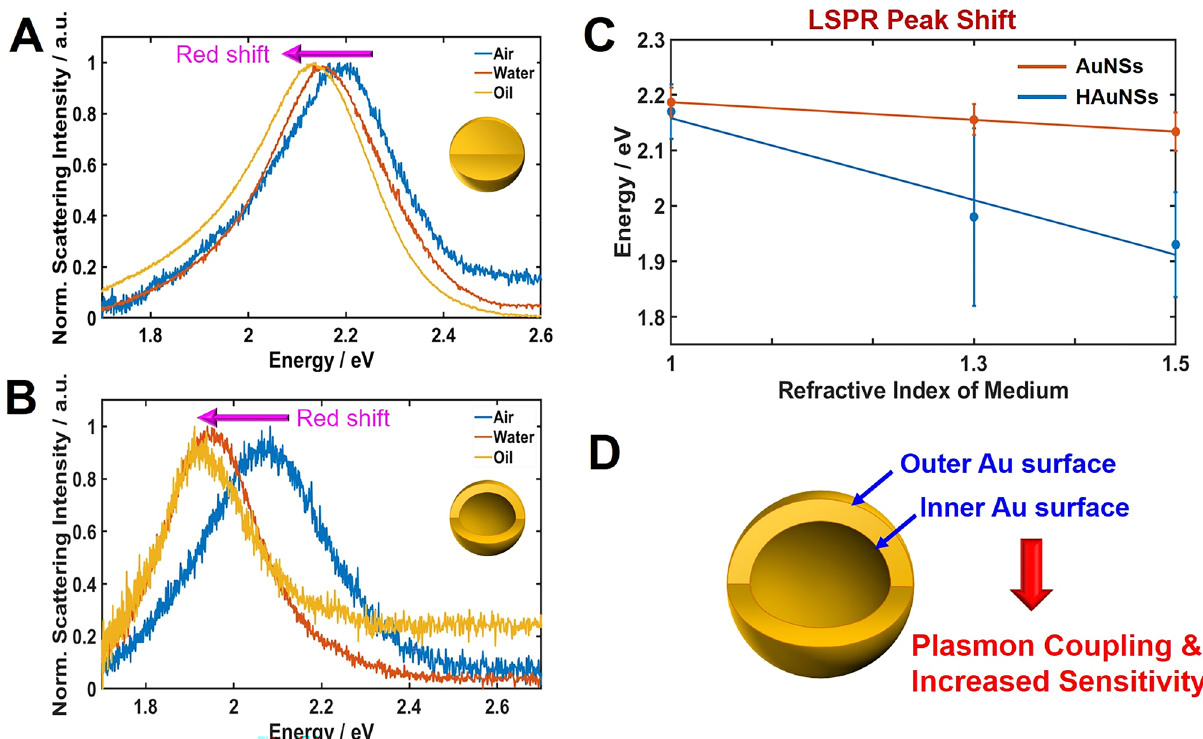
Figure 3. Change in the LSPR scattering spectra of single AuNS ( A ) and HAuNS ( B ) in the different local RI media: air, water, oil. ( C ) LSPR wavelength shifts for AuNS (red) and HAuNS (blue) as a function of the local RI of medium. ( D ) Schematic to show plasmonic coupling between the inner and outer surface of the Au RI media used. The energy peaks for A, B, and C were plotted against the three different RI media (air, water, and oil) with corresponding values equal to 1.00, 1.33, and 1.52, respectively (Fig. 4D). A linear relationship was observed between the peak energies for A, B, and C and the local RI media. The slopes that were determined from a fitting function were 0.153 (R 2 = 0.9398), 0.105 (R 2 = 0.9983), and 0.048 eV·RIU −1 (R 2 = 0.9895) for A, B, and C, respectively. It should be noted that the IF in A at longer wavelength sides exhibited a better sensitivity with regard to the IF in C at the shorter wavelengths side. The LSPR peak maxima (B) is shown in Fig. 4E. It should be noted that LSPR IF A at the longer wavelength side showed the highest sensitivity in regard to LSPR IF C (shorter wavelength side) and the LSPR maxima peak (B) as presented in Fig. 4E. To deepen our understanding on the effect of inner cavity of HAuNSs on the RI sensitivity of the LSPR IFs, scattering experiments using DF microscopy and spectroscopy were carried out for HAuNSs. The RI sensitivity of HAuNSs at the LSPR IFs was compared with solid AuNSs with similar size as shown in Fig. 4. Similar to AuNSs in Fig. 4, the first- and second-derivatives of the LSPR scattering spectra of HAuNSs were also obtained. The experimental LSPR scattering spectra of a single HAuNS and its corresponding first- and second-order deriva- tives are shown in the first, second and third rows of Fig. 5A–C, respectively. The LSPR scattering peak maxima (B) were located at 2.09, 1.95 and 1.91 eV for air, water and oil, respectively. The local maxima and minima of the first-order derivatives (two LSPR IFs shown by markers in A and C, respectively) occurred at 1.99/2.19, 1.85/2.03 and 1.82/2.01 (eV/eV) for the three different RI media (air, water, and oil), respectively. To check the compatibility of the experimental results shown in Fig. 5, we measured the LSPR scattering spectra of more than 20 HAuNSs in each local RI environment. The experimental data showed good agreement for all the HAuNSs analyzed. The LSPR peak maxima (B) were 2.08 (± 0.026), 1.98 (± 0.028), and 1.92 (± 0.037) eV for air, water and oil, respectively. Similarly, the LSPR IFs, A and C, were 1.98 (± 0.049) and 2.22 (± 0.049), 1.84 (± 0.160) and 2.05 (± 0.160), and 1.82 (± 0.094) and 2.02 (± 0.094) eV, for air, water, and oil, respectively. The peak energies for A, B, and C were plotted vs. local air, water, and oil RI media. A linear relationship was observed for the peak energies at A, B, C with respect to the three different local RI media, as presented in Fig. 5D. From the fitting function, the slopes were 0.570 (R 2 = 0.9685), 0.493 (R 2 = 0.9868) and 0.416 eV·RIU −1 (R 2 = 0.9998) for A, B, and C, respectively. Similar to the results for the AuNSs, the LSPR IF A showed the highest sensitivity with regard to the LSPR IF C and the LSPR peaks maxima (B) as demonstrated in Fig. 5E. This result was consistent with the AuNSs (Fig. 4). Thus, a higher RI sensitivity was observed for both AuNSs and HAuNSs at the LSPR IF A at the longer wavelength side than the LSPR peak maximum (B). We further compared the RI sensitivity at the LSPR maximum and IFs for both AuNSs and HAuNSs. The RI sensitivity of the HAuNSs was 3.7 times better than solid AuNSs at the position of the LPSR IF A (Fig. 6A). The RI sensitivity of the HAuNSs was 4.7 times better than solid AuNSs at the position of the LPSR peak maximum